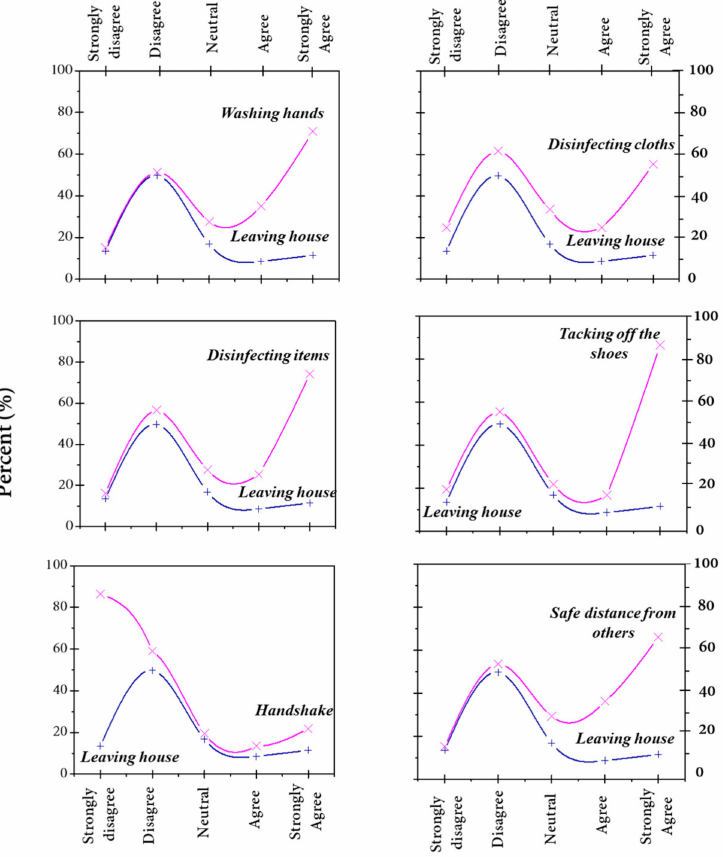
Figure 5. The relationships between leaving home and respecting sanitary measures.